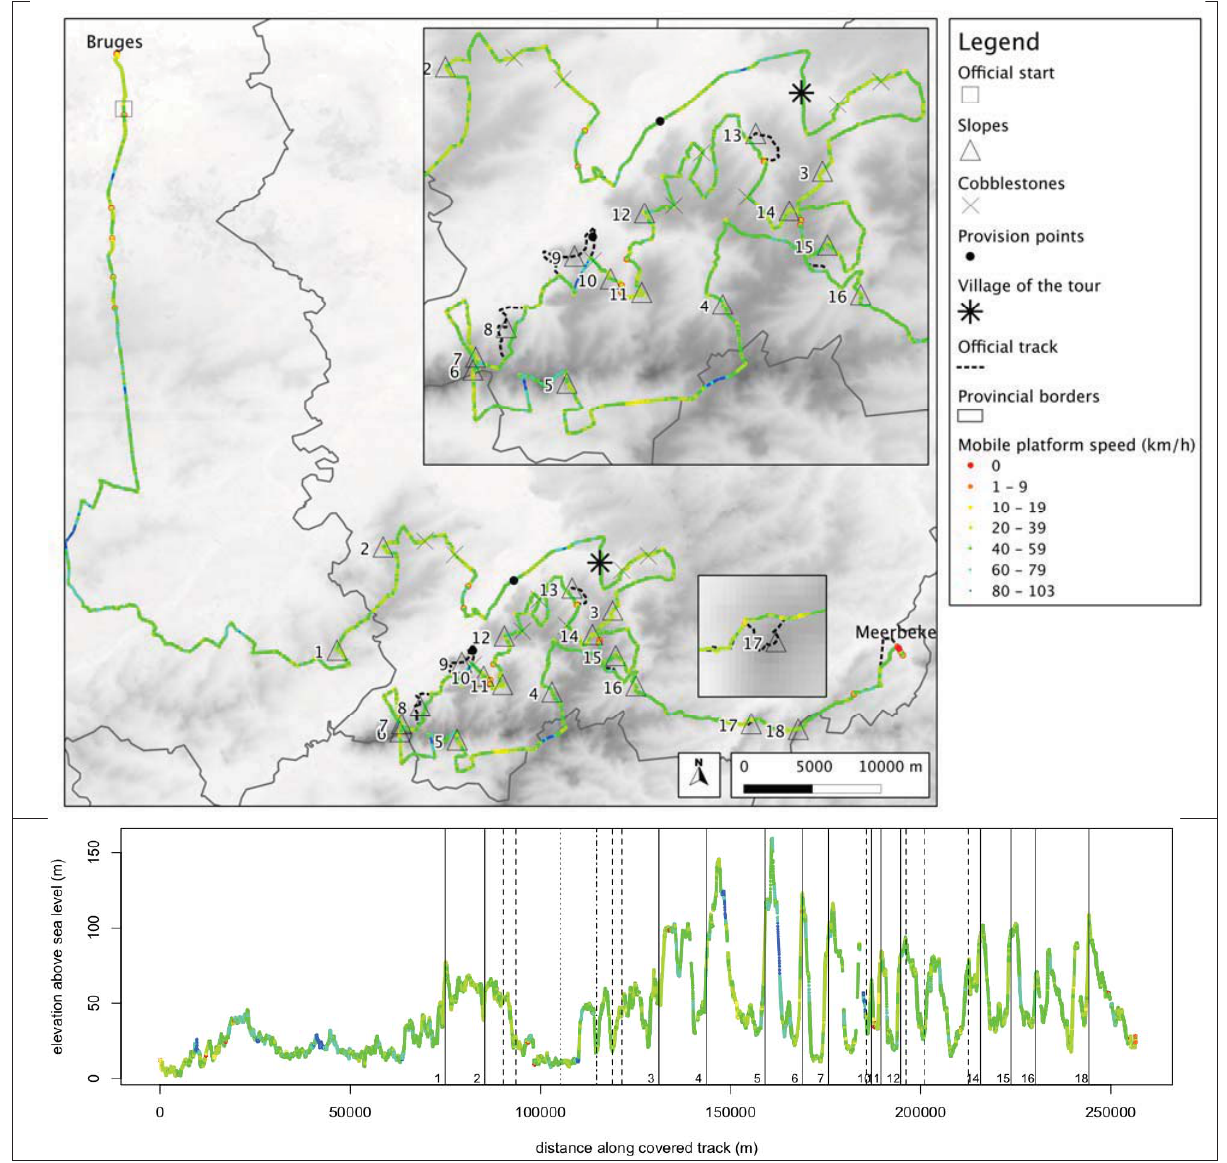
Figure 2. Tour of Flanders, 2011 edition. Top: spatial view of the official track and the trajectory of the mobile platform. Bottom: elevation profile of the mobile platform trajectory (NASA Shuttle Radar Topography Mission elevation data). In both cases, the speed of the mobile platform is shown in a color scale ranging from red (temporary stops) to blue (more than 80 km/h). The 18 official climbs are shown as triangles in the spatial view and solid vertical lines in the elevation profile (non covered climbs excluded). The dashed vertical lines represent the cobblestoned segments, the dotted vertical line the first provision point, and the dashed-dotted line the village of the